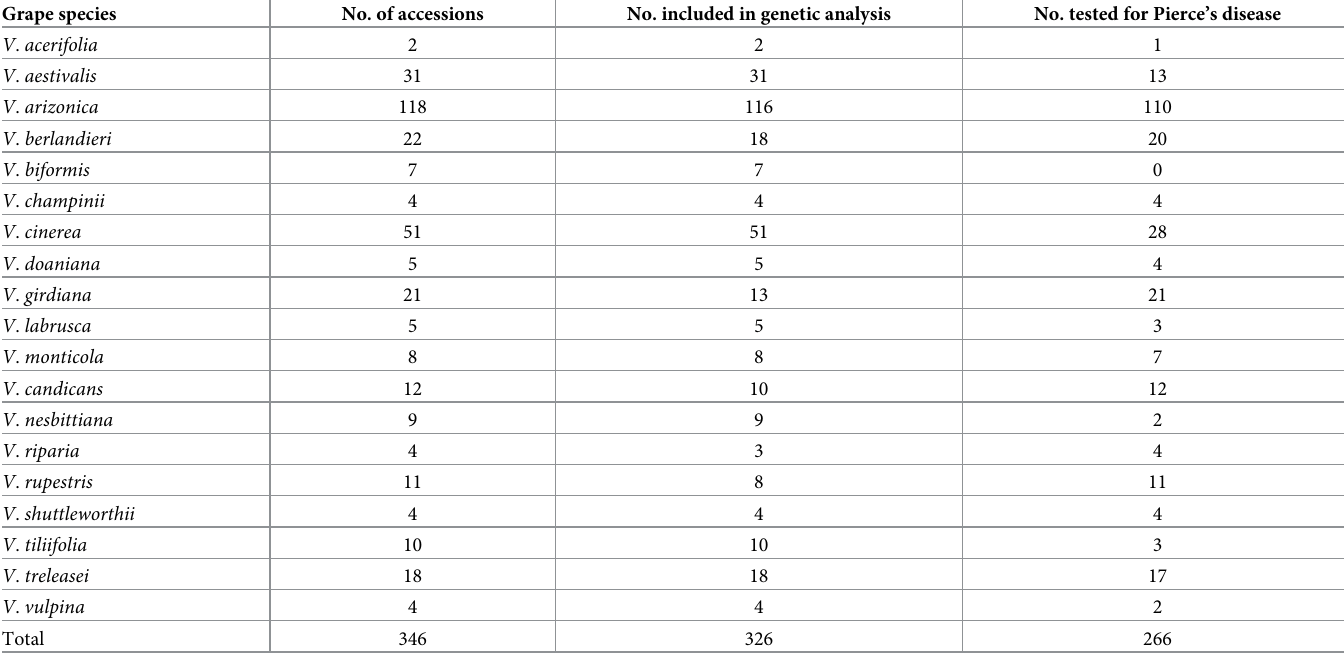
Table 1. Summary of evaluated germplasm by species. Simple sequence repeat marker data were generated for 346 accessions from 19 grape species and 326 were included in the genetic analysis study. The greenhouse-based screen for PD resistance was completed for 266 accessions. Grape